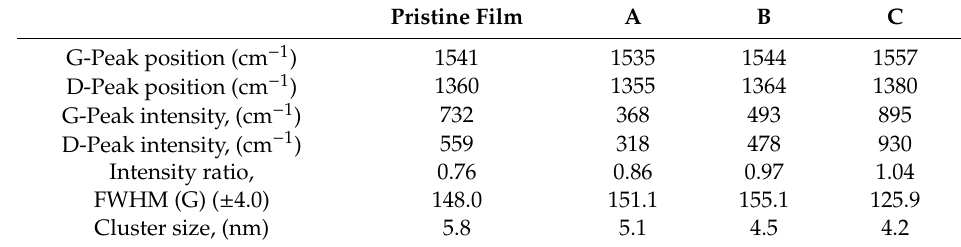
Figure 1 . Raman spectra for ( a ) pristine a-C and ( b – d ) Ag:a-C nanocomposites at various fluences. Table 1. Summary of Raman parameters for pristine and Ag irradiated amorphous carbon films. Pristine